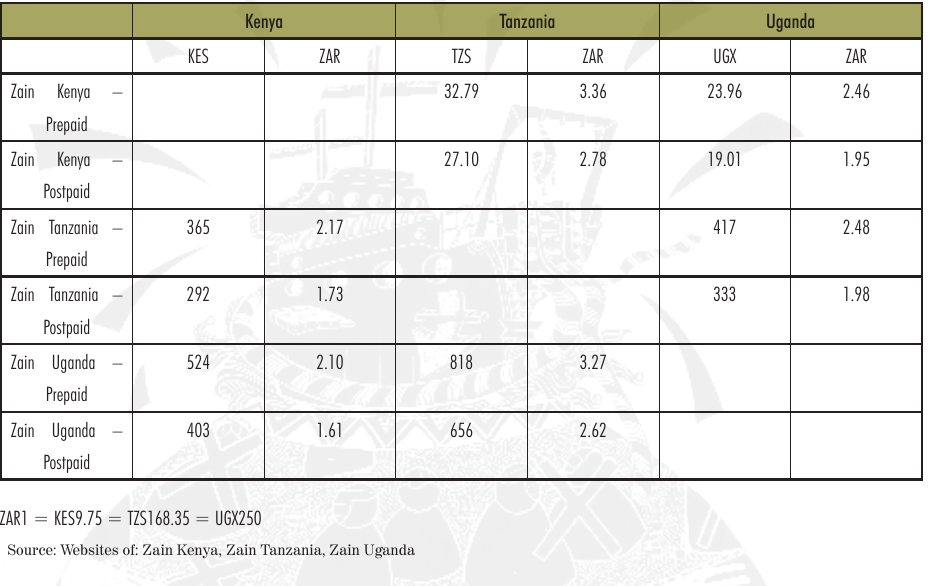
ZAIN ONE OFFICE GPRS TARIFFS IN EAST AFRICA IN